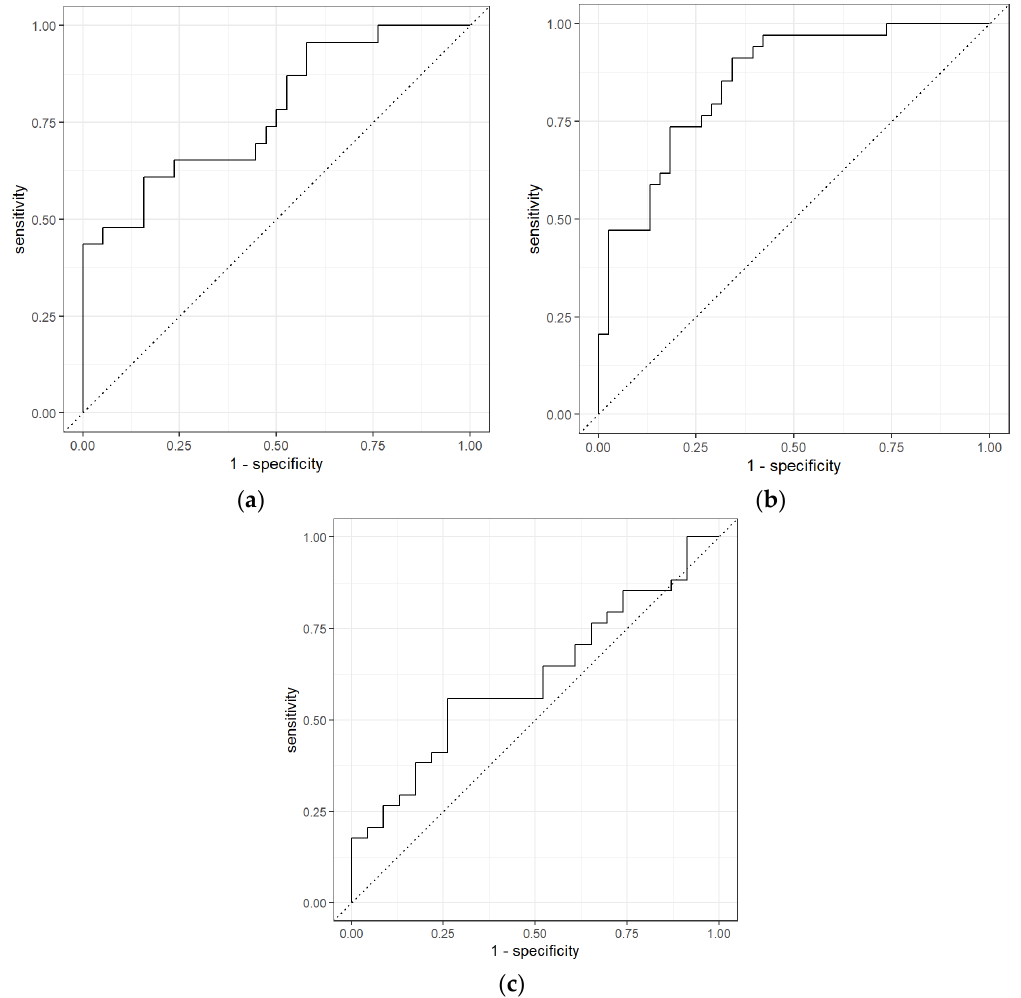
Figure 8. ROC for different stages of CRC vs. non-Cancer: ( a ) early-stage CRC vs. non-cancer using Random Forest classifiers, ( b ) late-stage CRC vs. non-cancer using Neural Network, and ( c ) early-stage CRC vs. late-stage CRC using Neural Network using the PEN3 analytical device.